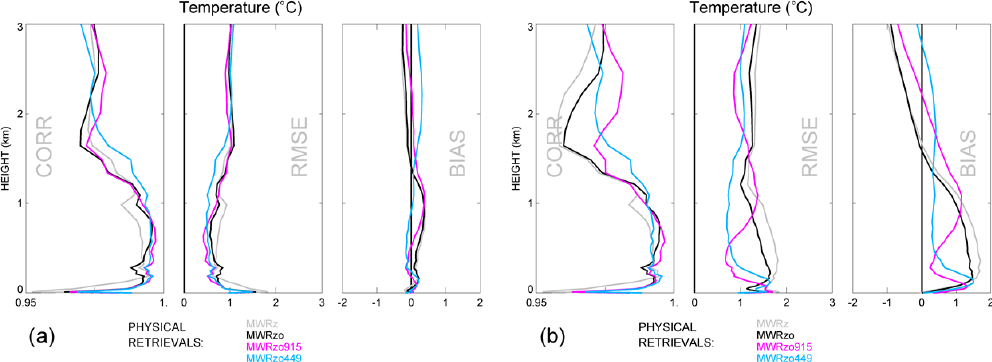
Figure 6. Pearson correlation, RMSE, and mean bias for temperature profiles of MWRz in gray, MWRzo in black, MWRzo915 in magenta, and MWRzo449 in light blue for the radiosonde BC bias-correction method in (a) and TROPoe BC method in (b) .